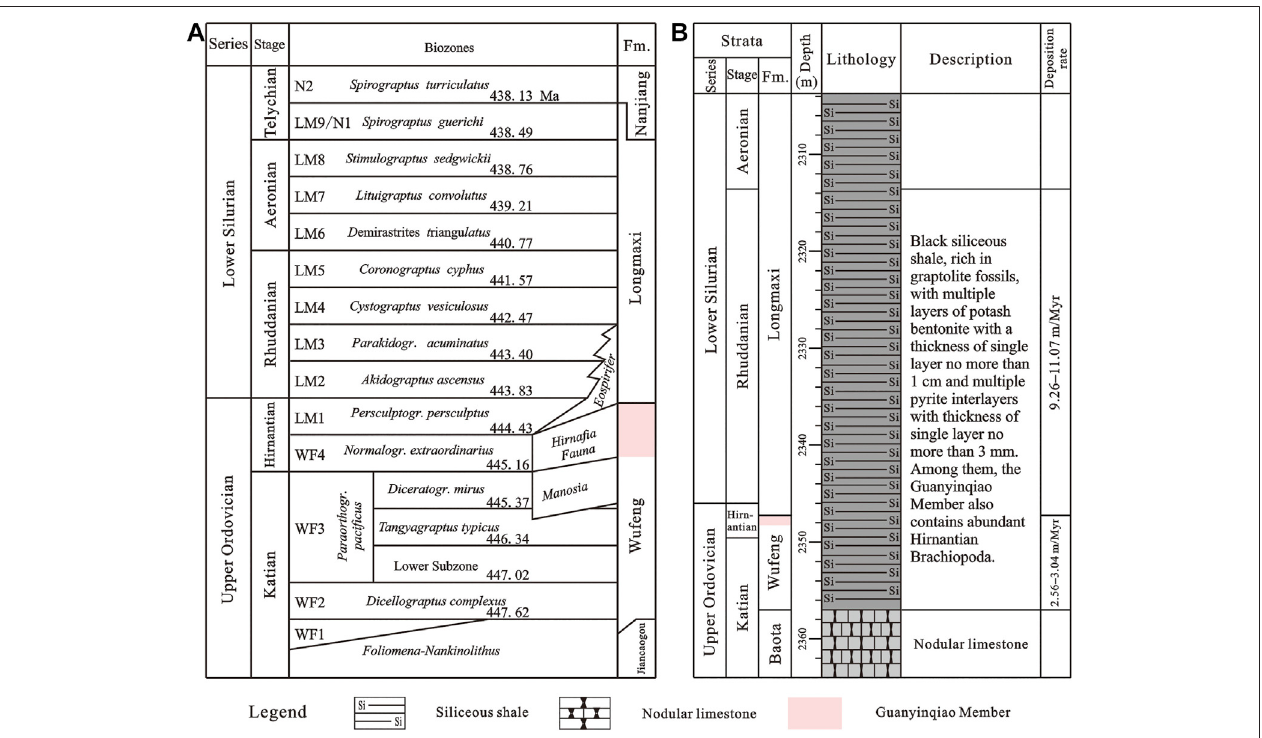
FIGURE 3 | (A) Graptolite biozones in the Wufeng – Longmaxi Formation in the Yangtze Region, according to Chen et al. (2015). (B) Stratigraphic column for well N211.